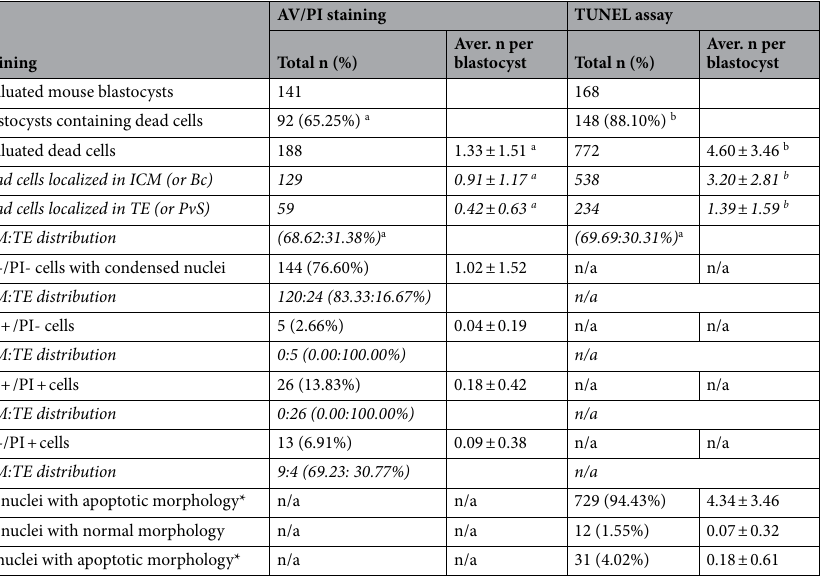
Table 2. Frequency of embryonic cells showing features of apoptosis or secondary necrosis. Results are expressed as arithmetical means ± standard deviation or percentages. AV, annexin V; PI, propidium iodide; T, TUNEL labelling; ICM, inner cell mass; Bc, blastocoel; TE, trophectoderm; PvS, perivitelline space; *apoptotic morphology: condensed nuclear chromatin usually decayed into smaller fragments. Different superscript letters indicate significant differences. Statistical analysis: Proportion of blastocysts containing dead cells: Chi- squared test with one degree of freedom ( P < 0.0001); mean number of evaluated dead cells per blastocysts: Mann–Whitney U test ( P < 0.0001 for all cases); ICM:TE distribution: Chi-squared test with one degree of freedom ( P = 0.791).